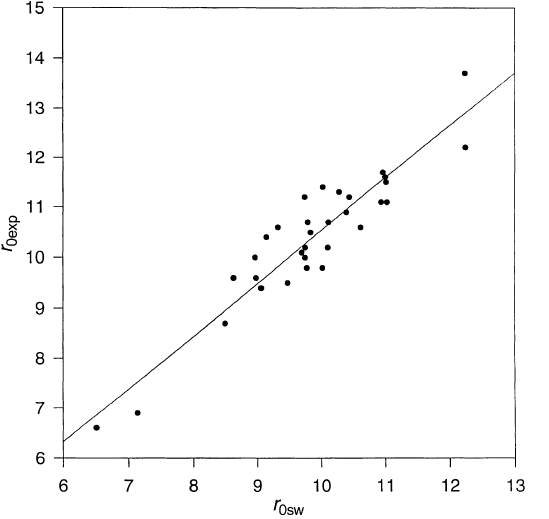
Fig. 9. Scatter plot of experimental magnetopause values of r 0 versus theoretical ones calculated from solar wind